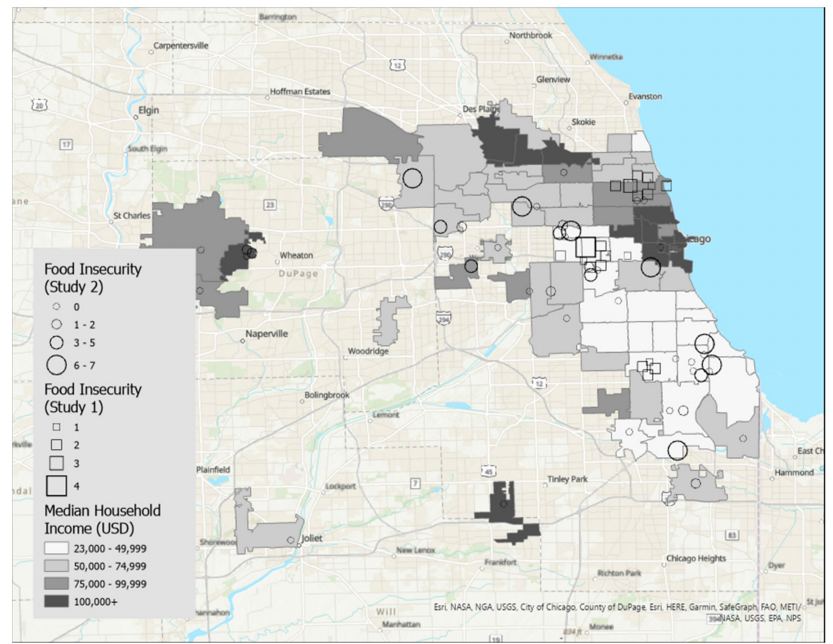
Figure 1. This figure displays food insecurity overlaid on a map of median income. The map shows that participants with the highest food insecurity (larger symbols) tend to live in the zip codes with the lowest median income. In contrast, participants with low food insecurity were dispersed broadly across zip codes, with participants represented in all income